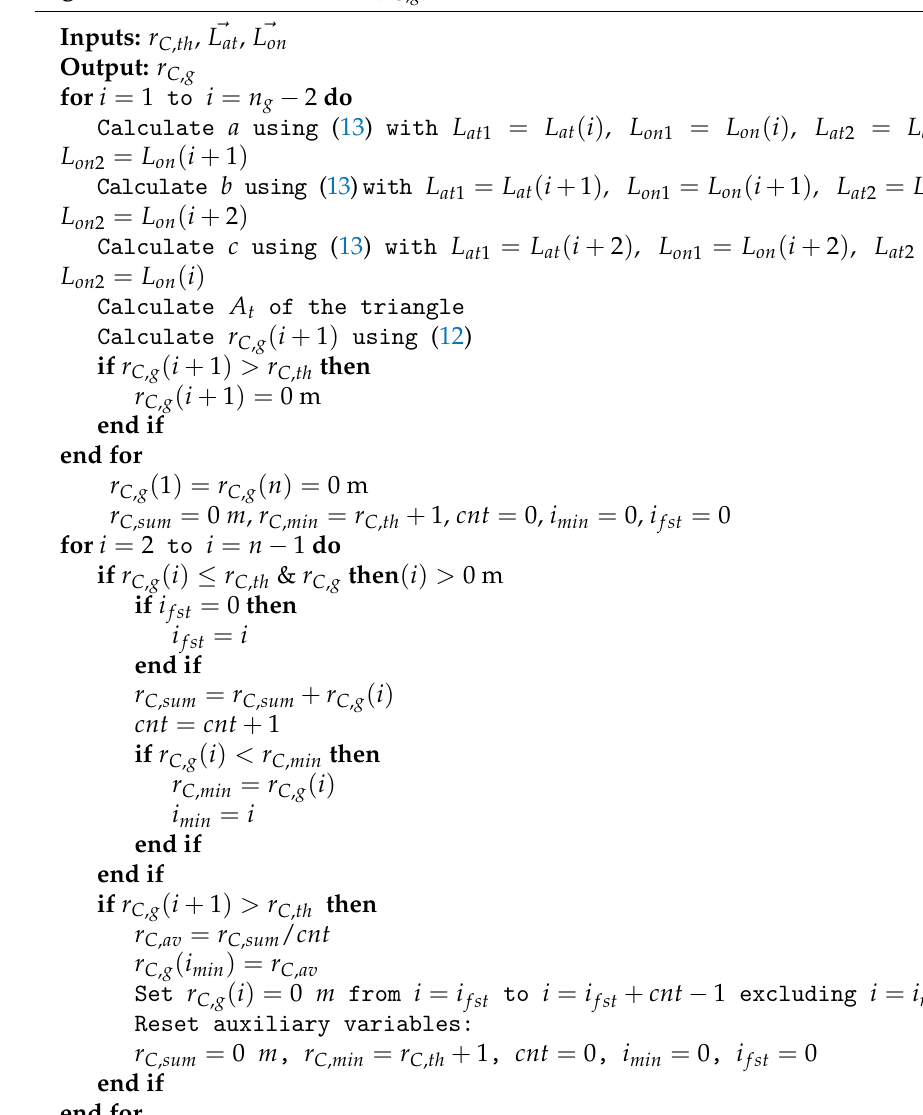
Algorithm 1 Curvature radius ( (cid:126) r C , g )